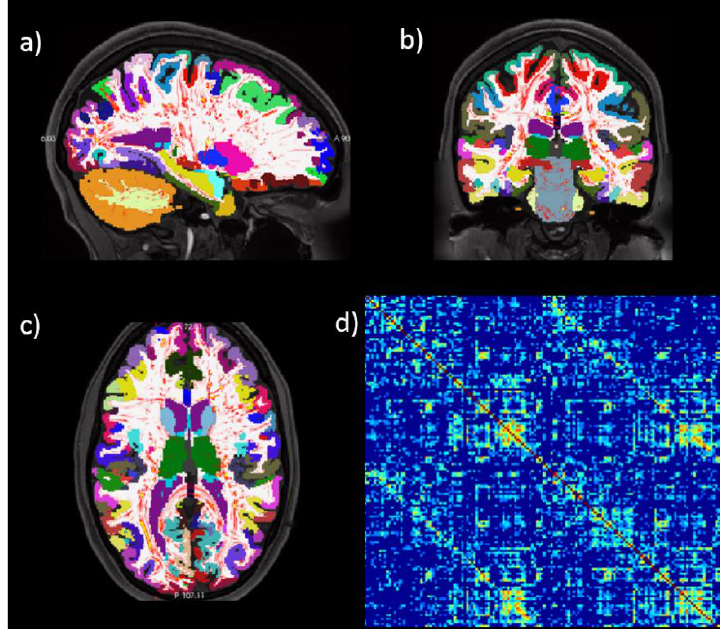
Figure 3. Human connectome estimation. The image shows an example of connectome generation from MR images: ( a–c ) MR anatomical images can be segmented into several meaningful regions, diffusion imaging provides an estimation of axonal connections linking each pair of parcels (red tracts) for the construction of the structural connectome matrix ( d ).